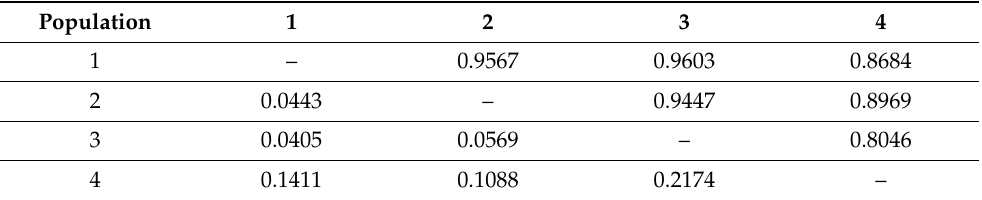
Table 5. Nei’s original measures of genetic identity and genetic distance [37]. Nei’s genetic identity (above diagonal) and genetic distance (below diagonal).